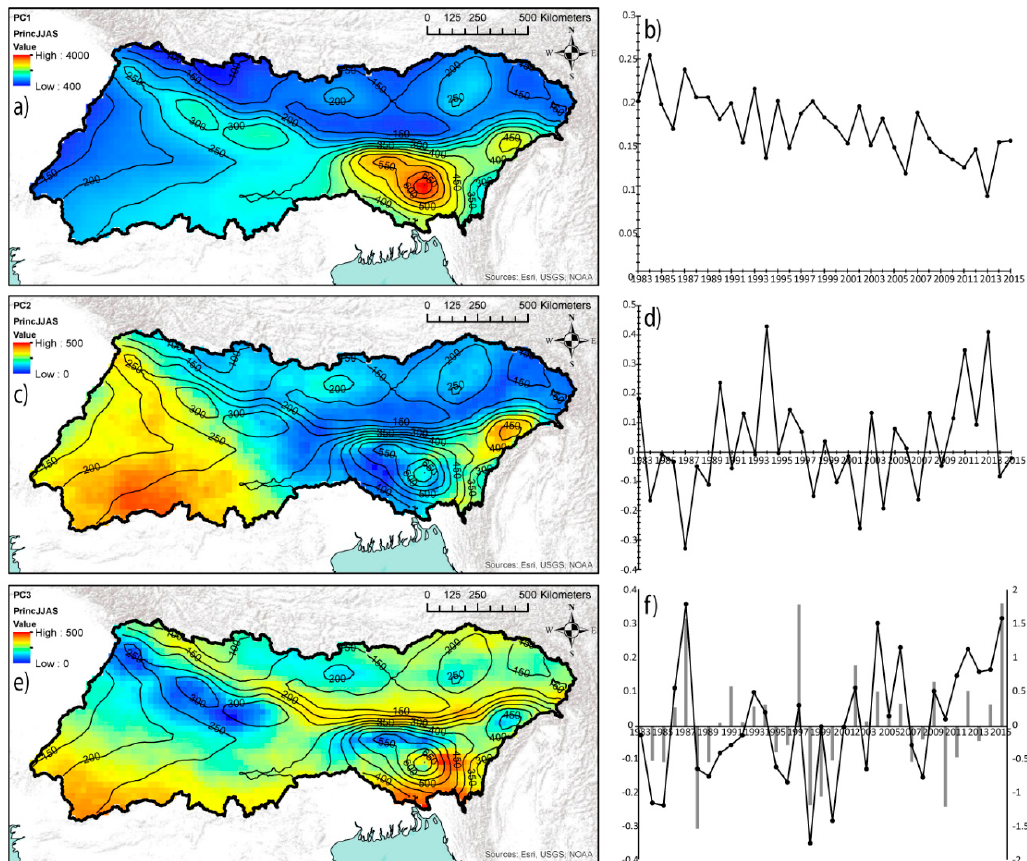
Figure 2. June-July-August-September (JJAS) precipitation patterns in the GBM from 1983 to 2015 as revealed by principal component (PC) analysis. Contours are climatological precipitation as in Figure